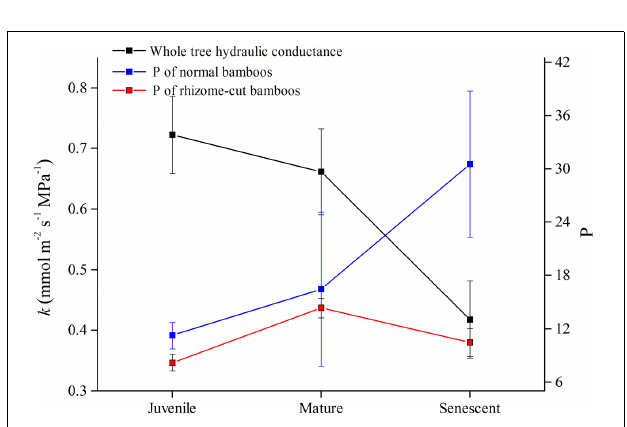
FIGURE 5 | Values for k and P in normal and rhizome-cut bamboos of different ages.